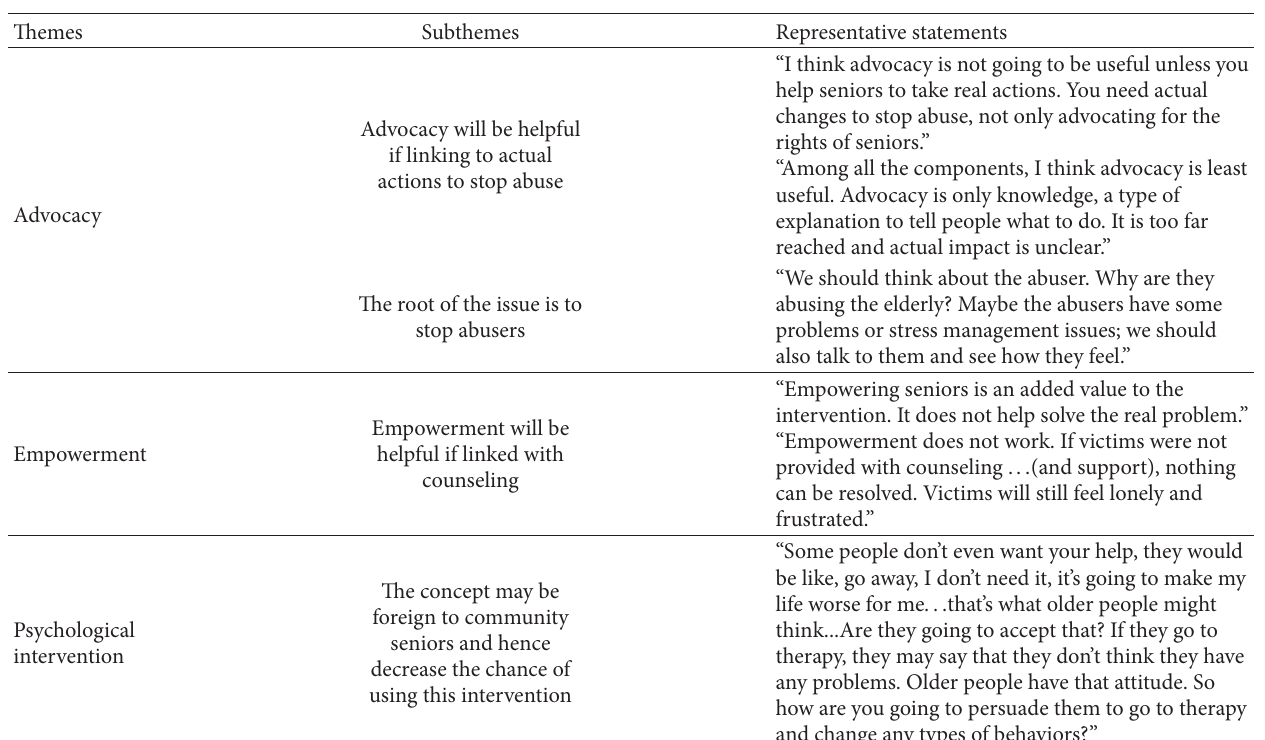
Table 4: Perceived challenges in the design of